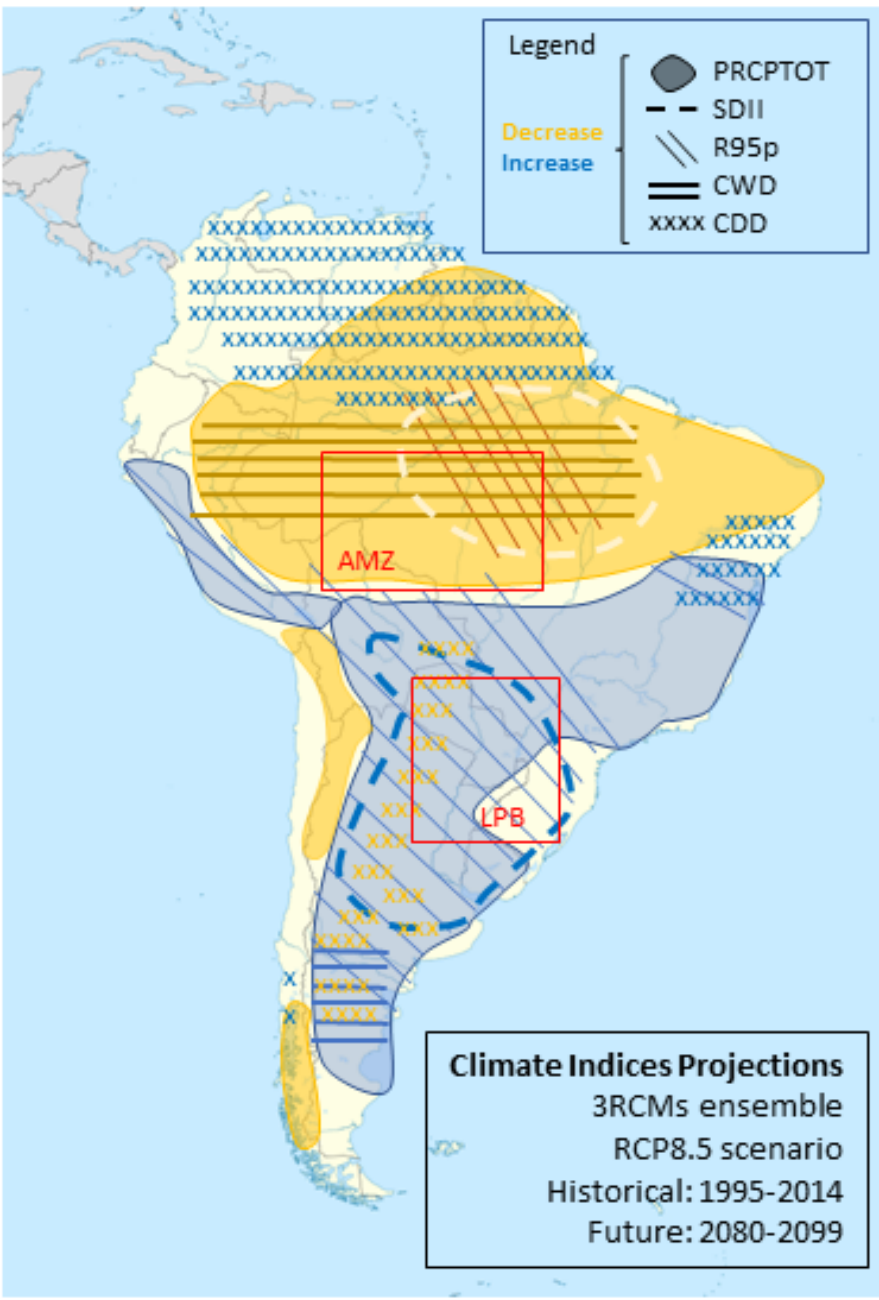
Figure 11. Schematic representation of the projected changes for the precipitation climate indices based on the 3RCMs ensemble under RCP8.5 at the end of the century (2080–2099). Red boxes indicate the location of the subdomains in the Amazon and La Plata basins.